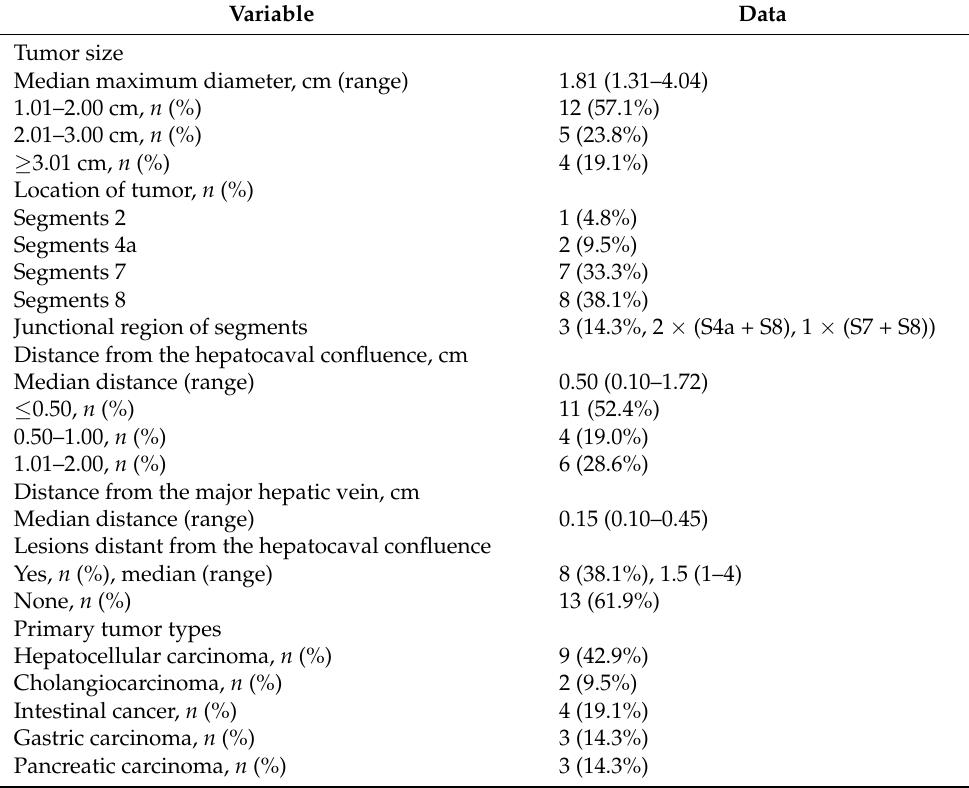
Table 2. Characteristics of lesions at the hepatocaval confluence.